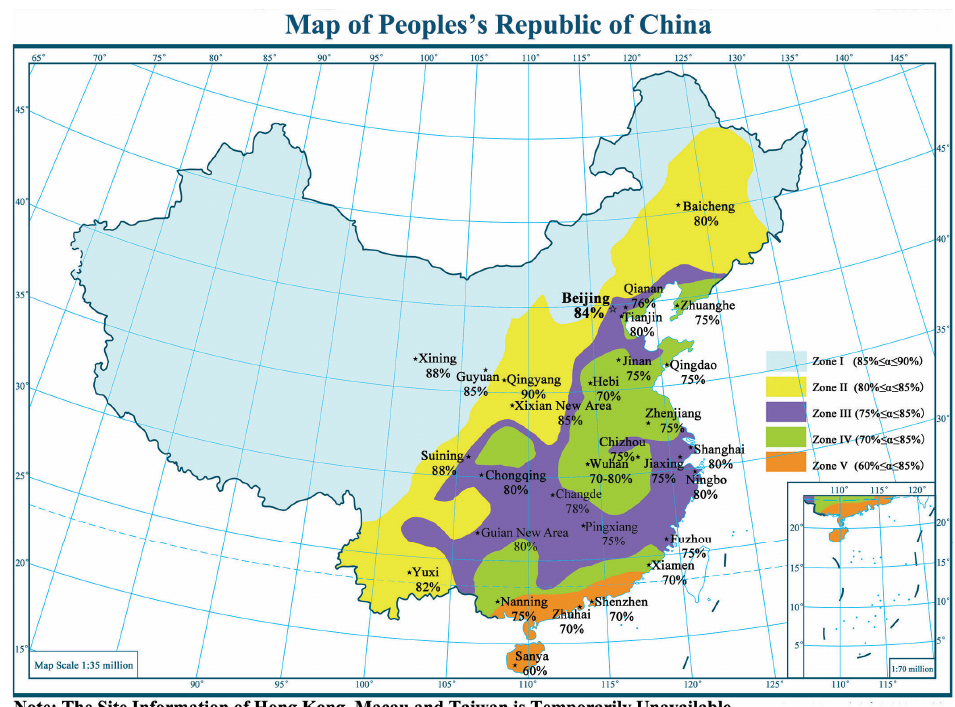
Figure 4. Location of 30 national pilot sponge cities in China (reprinted with permission from Ref. [13]. 2020, Haifeng